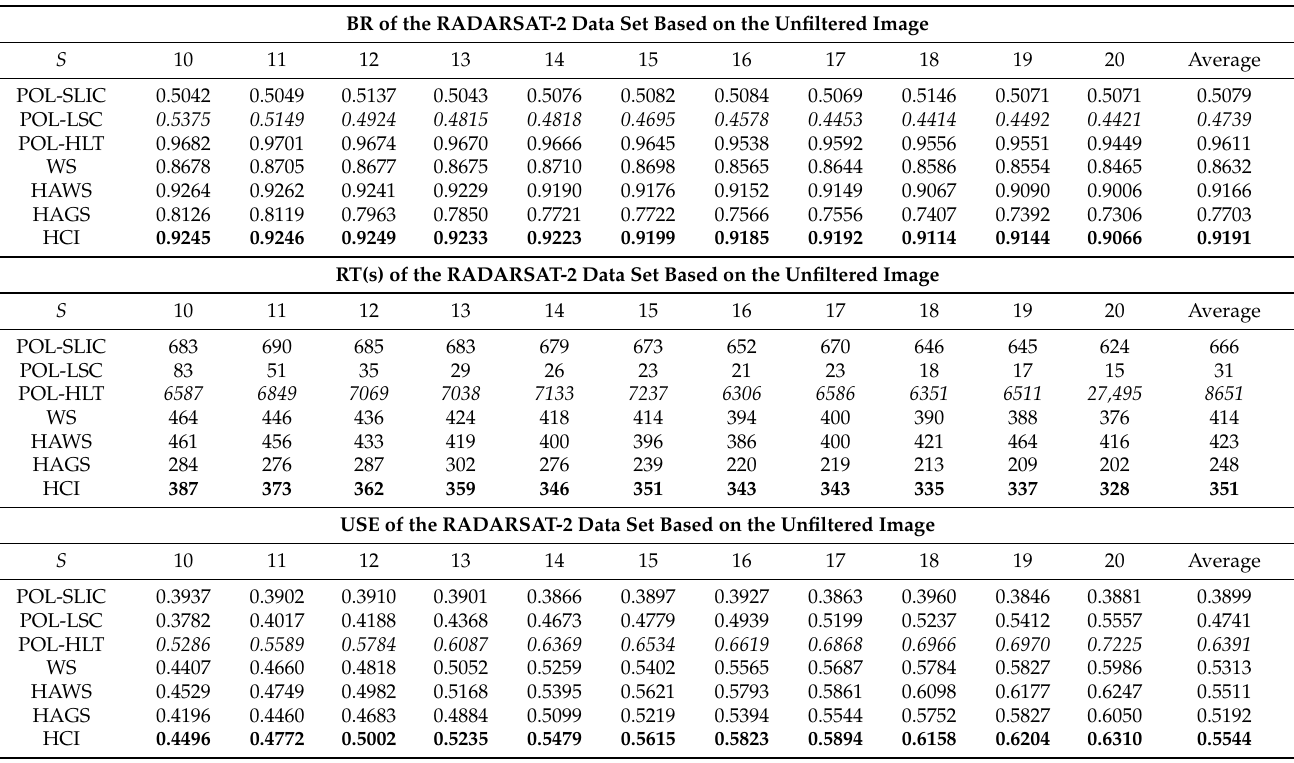
Table 3. BR, RT(s) and USE of the RADARSAT-2 data set based on the unfiltered image. BR of the RADARSAT-2 Data Set Based on the Unfiltered